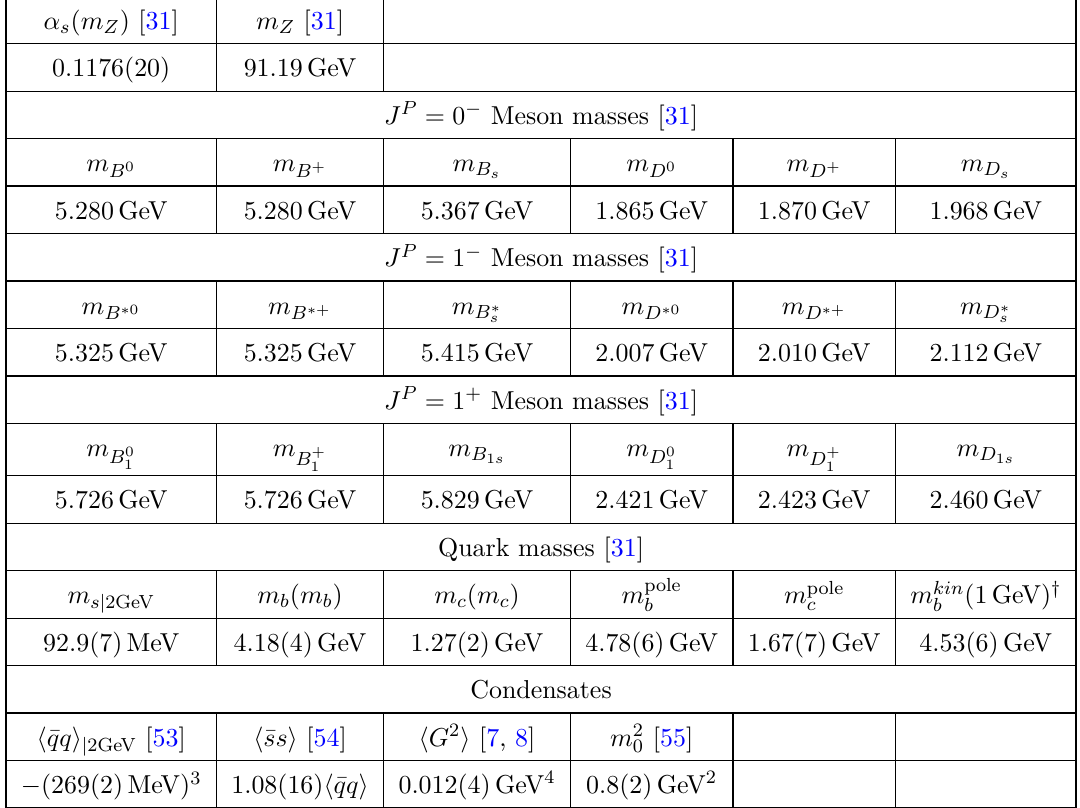
) conversion between s